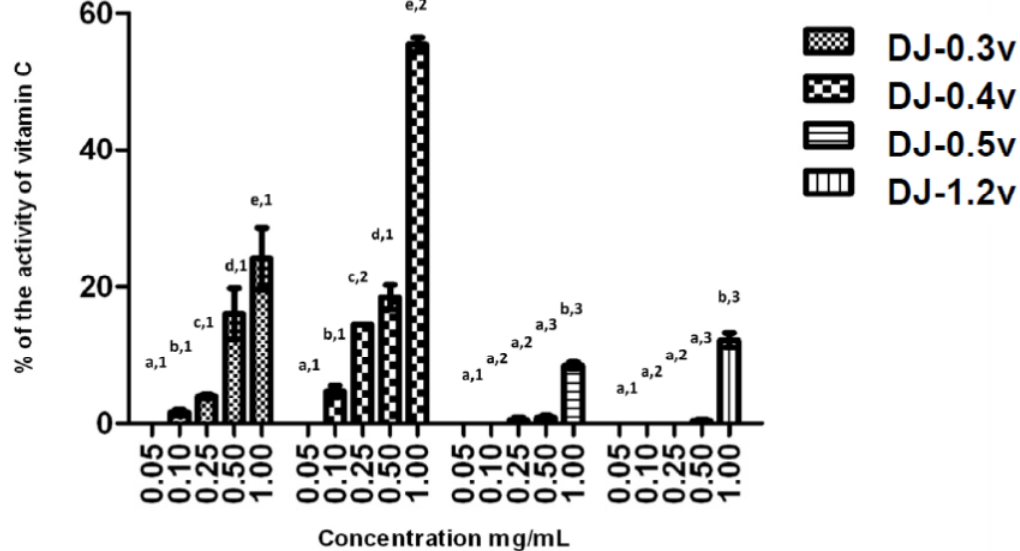
Figure 2. Reducing power of sulfated polysaccharides from D. justii . Data are expressed as means ± standard deviation. Reducing power is expressed as a percentage of the activity shown by 0.2 mg/mL of ascorbic acid. Different letters ( a , b , c , d , e ) indicate a significant difference between concentrations of individual algal sulfated polysaccharides by one-way ANOVA followed by Student-Newman-Keuls test ( p < 0.05). Different numbers (1, 2, 3, 4) indicate a significant difference ( p < 0.05) between the same concentrations of different sulfated